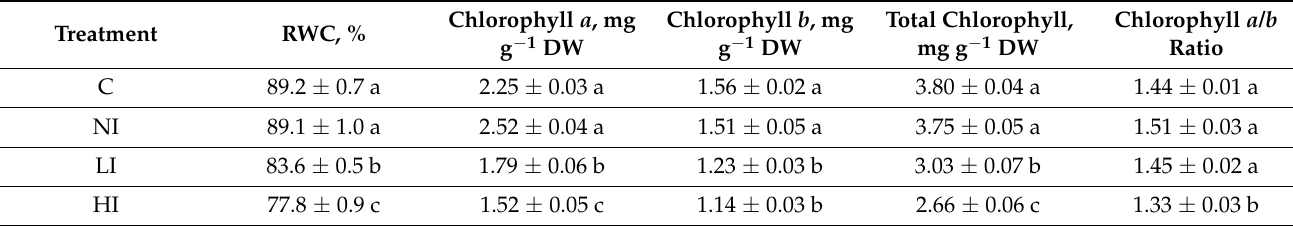
Table 1. Effect of mistletoe infestation on relative water content and chlorophyll content in linden leaves.